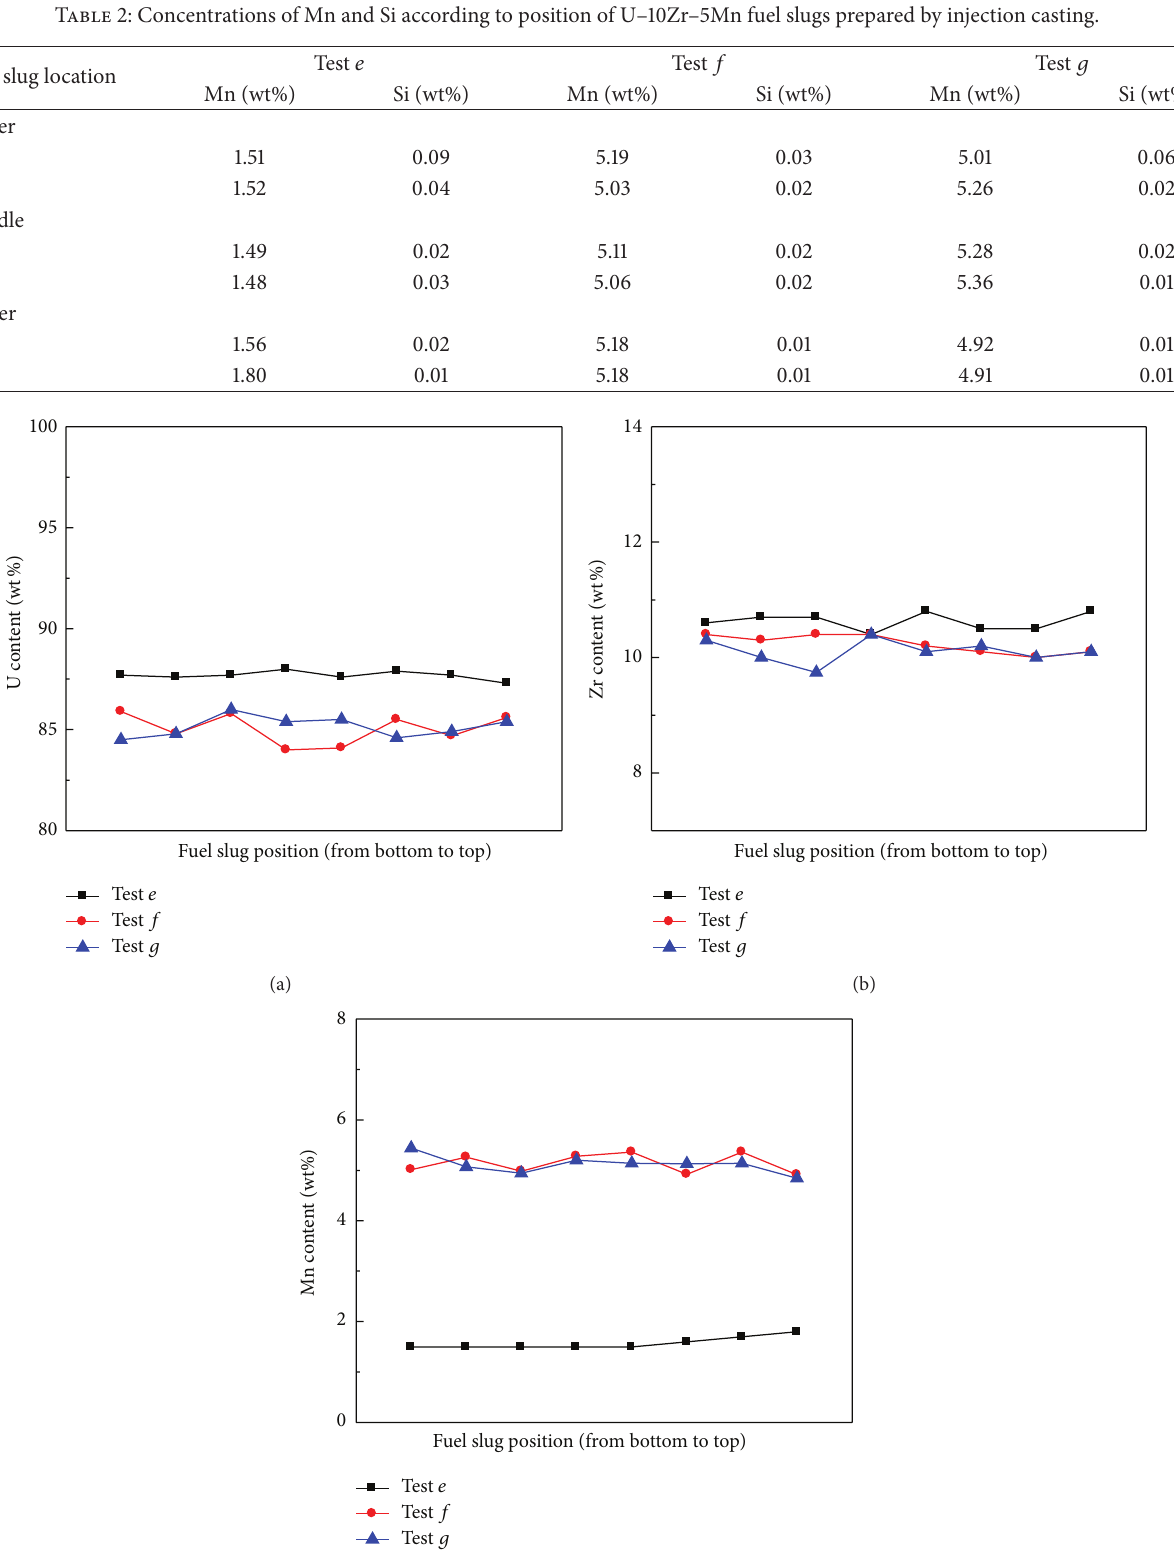
Figure 6: Variations of chemical composition according to the position of a U–Zr–Mn fuel slug fabricated under different injection casting conditions: (a) U, (b) Zr, and (c)